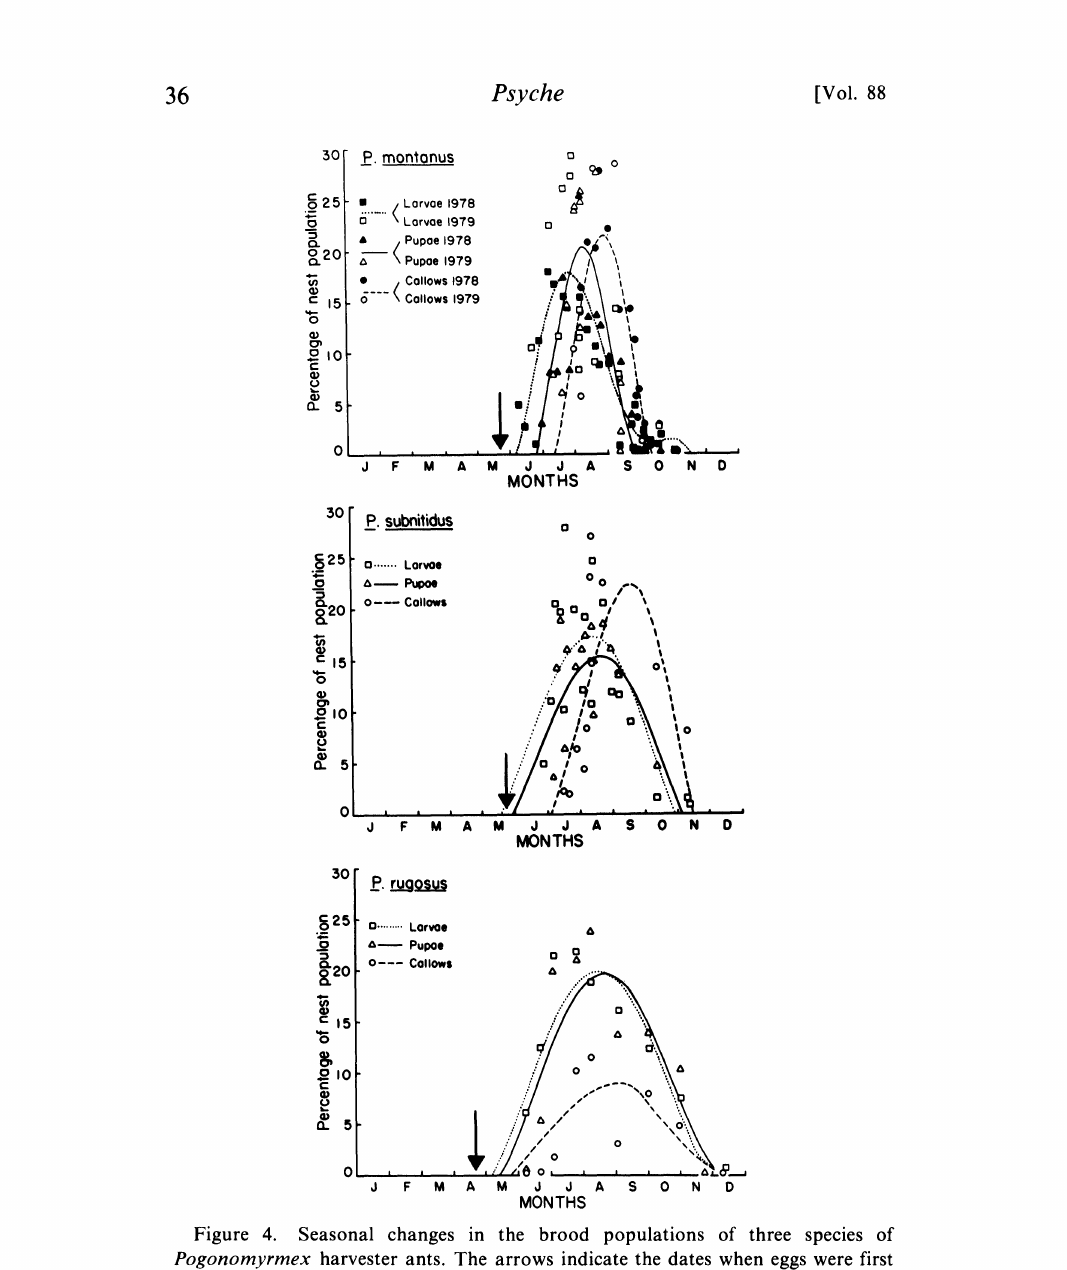
Figure 4. Seasonal changes in the brood populations of three species of Pogonomyrmex harvester ants. The arrows indicate the dates when eggs were first found in the nests. Nests excavated which contained only adult workers are not represented in the